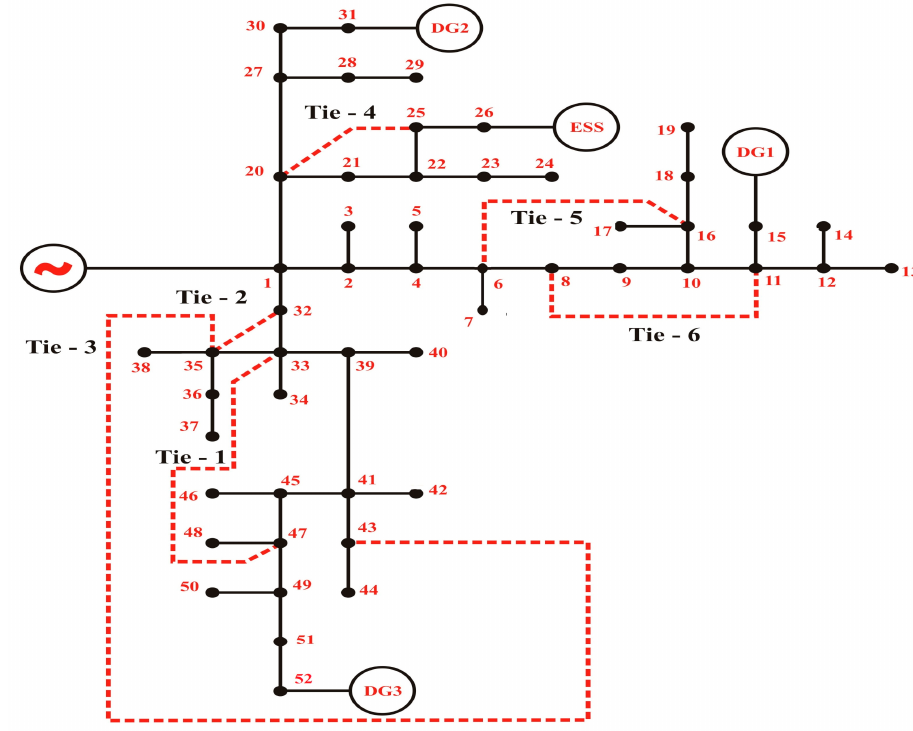
Figure 13. Practical Indian 52-bus system of smart city.